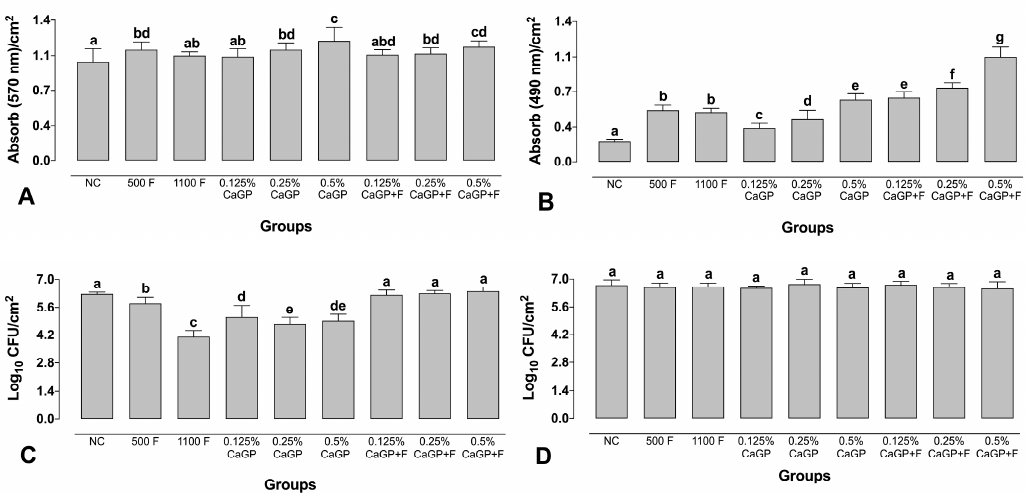
Figure 2. Absorbance values per cm 2 obtained for quantification of Total biomass ( A ), Metabolic activity ( B ), Logarithm of colony-forming units per cm 2 for Streptococcus mutans ( C ) Candida albicans ( D ) in dual-species biofilms. NC: negative control (untreated biofilms); CaGP: calcium glycerophosphate; F: fluoride. Error bars denote the standard deviations of the means. Different letters symbolize statistical differences among the groups (1-way ANOVA, Fisher’s LSD test, p < 0.05; n = 9).